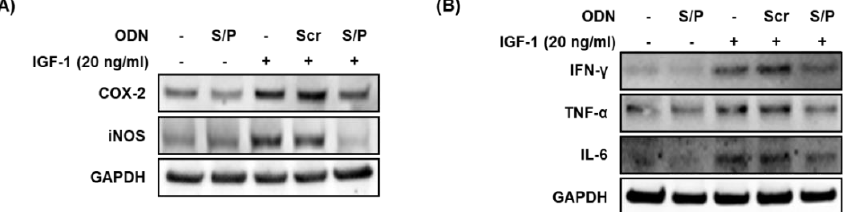
Figure 8. The SREBP/PPAR chimeric decoy ODN suppressed the activation of inflammatory factors in IGF-1-induced lipogenesis. ( A , B ) Western blot analysis results demonstrated that the SREBP/PPAR chimeric decoy ODN inhibited the expression of COX-2, iNOS, IFN- γ , TNF- α , and IL-6 in IGF-1- stimulated SZ95